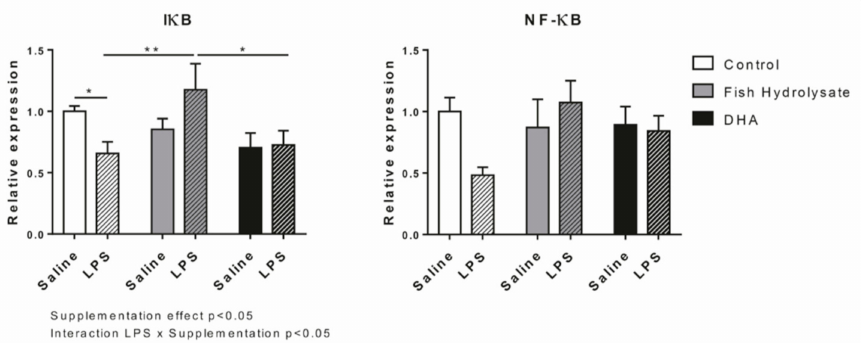
Figure 3. Protein expression of proinflammatory factors I κ B and NF- κ B in the hippocampus of mice fed orally with control solution (in white), fish hydrolysate (in grey) or DHA (in black) by daily gavage for 18 days, 2 h following LPS injection (125 µ g/kg) (hatched bars) (* p < 0.05, ** p < 0.01 by 2-way ANOVA and Fisher’s LSD post hoc test; n = 4–6 per group). Data are presented as mean ± SEM. DHA: docosahexaenoic acid; LPS: